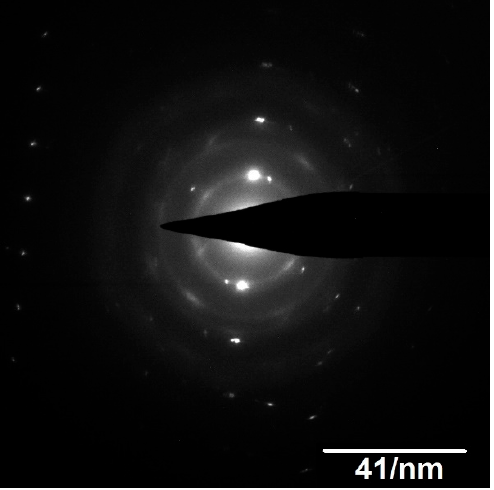
Figure 7. High-resolution TEM images of the UC 2 − y material ( a ) before and ( b ) after laser heating.